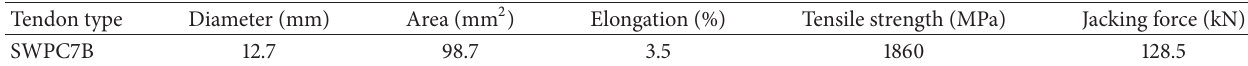
Table 1: Information on the prestress strand.